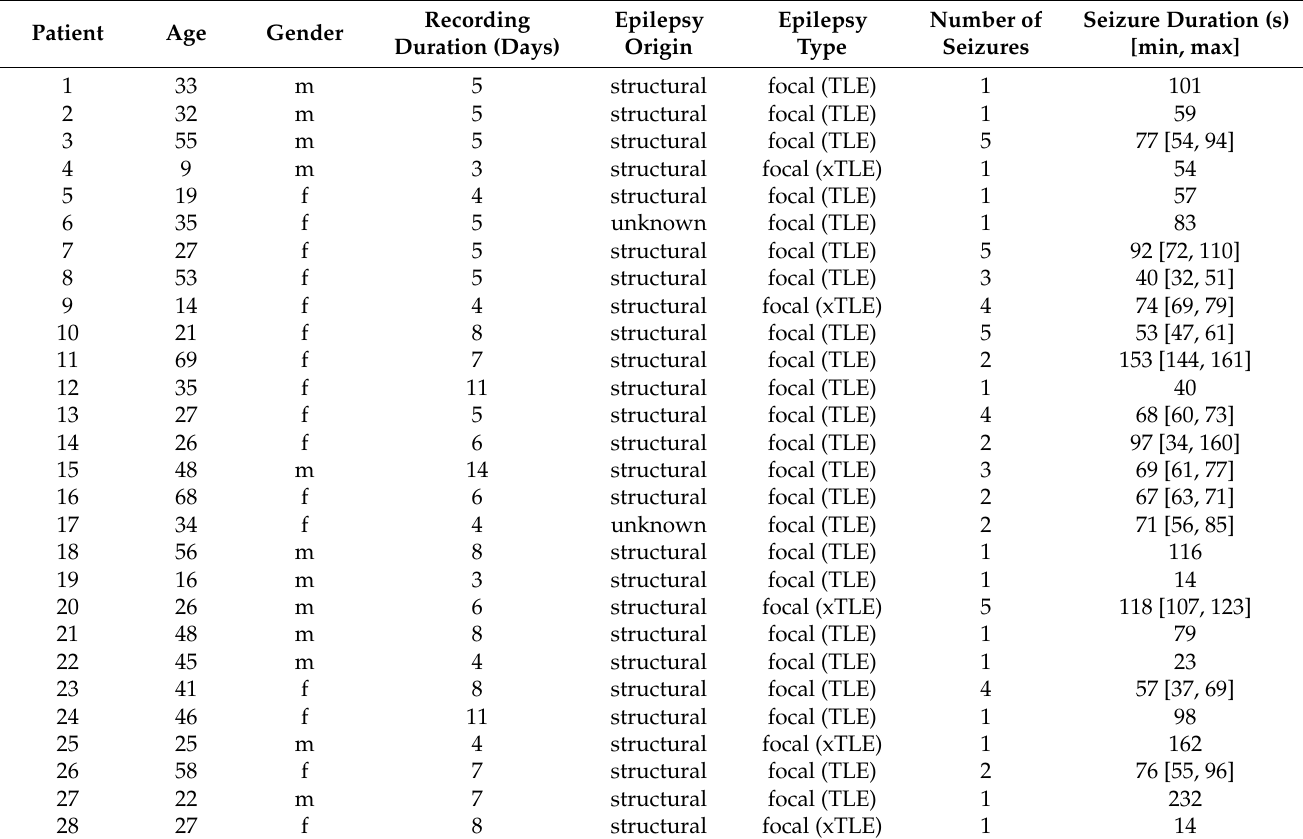
Table A1. Overview of patient demographics. TLE = temporal lobe epilepsy, xTLE = extratemporal lobe epilepsy.